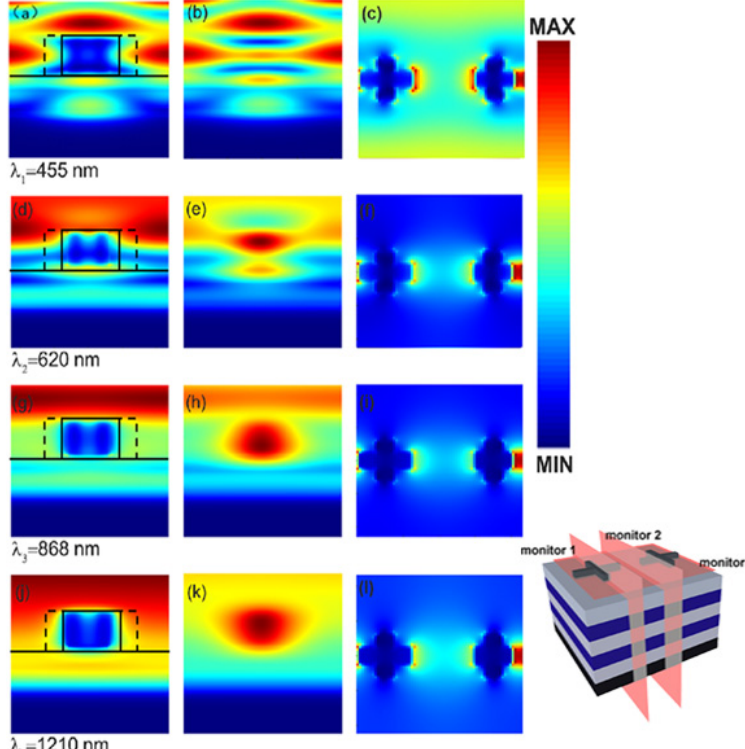
Figure 4. The electric field distribution at different positions as the light with various wavelengths, λ 1 = 455 nm ( a – c ), λ 2 = 620 nm ( d – f ), λ 3 = 868 nm ( g – i ), and λ 4 = 1210 nm ( j – l ), incident onto the absorber. The electric field distributions in the first column are obtained from monitor 1. The data in the second column are obtained from monitor 2. The electric field distributions in the third column are obtained from monitor 3.